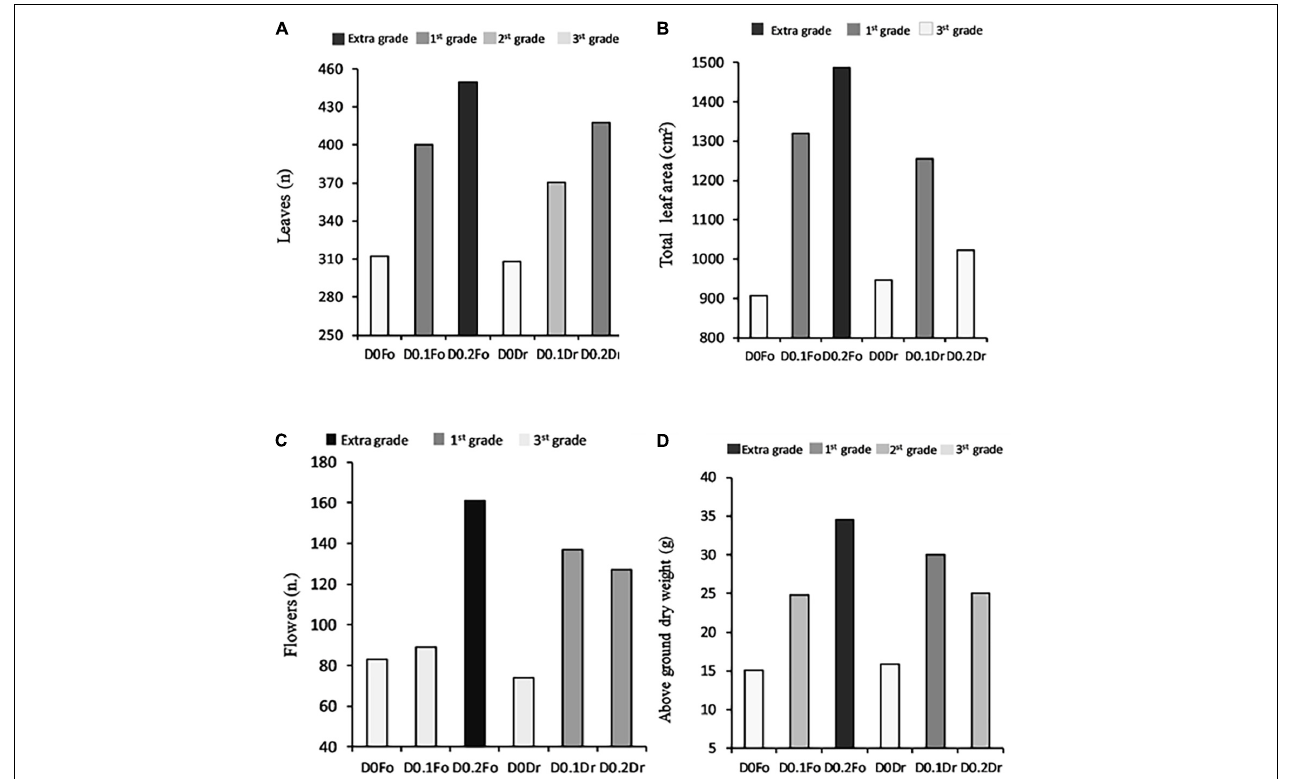
FIGURE 1 | Interaction effects of biostimulant dose (D0, D0.1, and D0.2) × application method (Fo = foliar spray and Rd = root drenching) on petunia plant grade [leaf number (A) , total leaf area (B) , flower number (C) , and dry weight of aboveground parts (D) ].